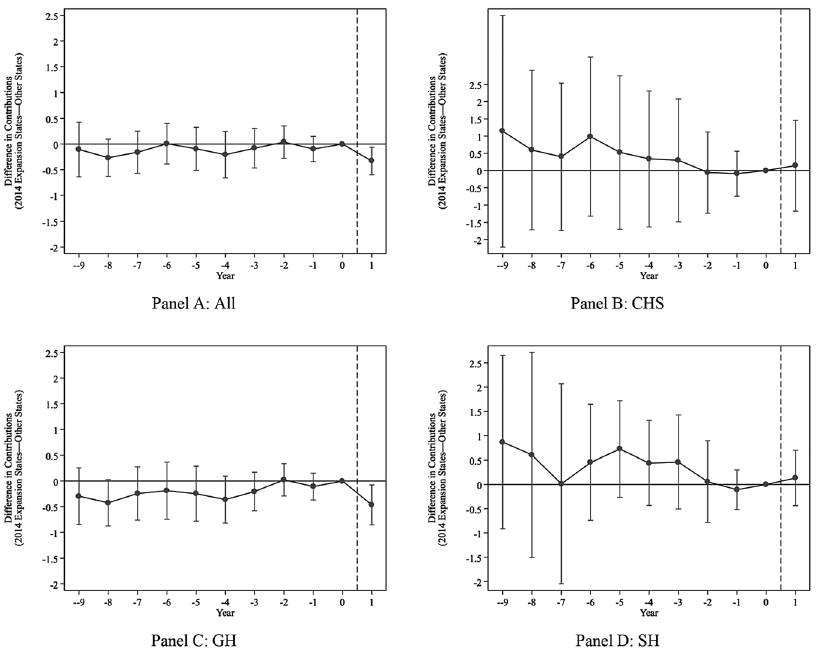
Figure 2: Differences in contributions between the expansion states and the non-expansion